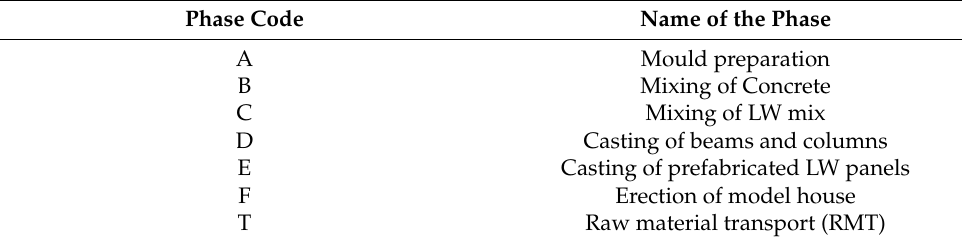
Table 3. Phases of the model house